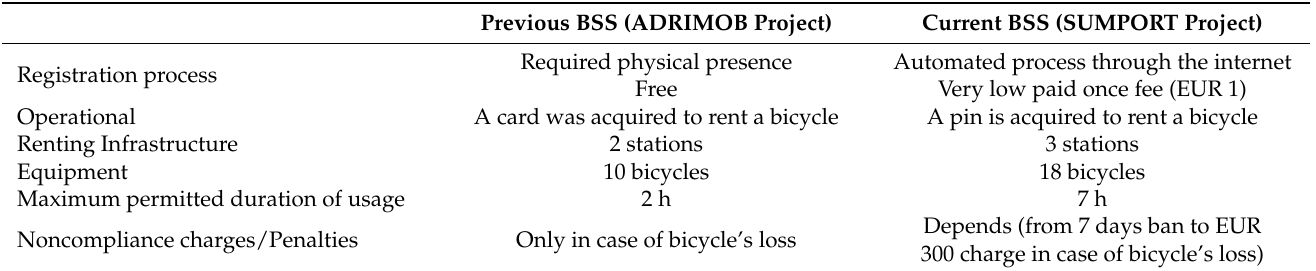
Table 2. Comparison of the previous and current forms of the bike-sharing system in the city of Igoumenitsa.